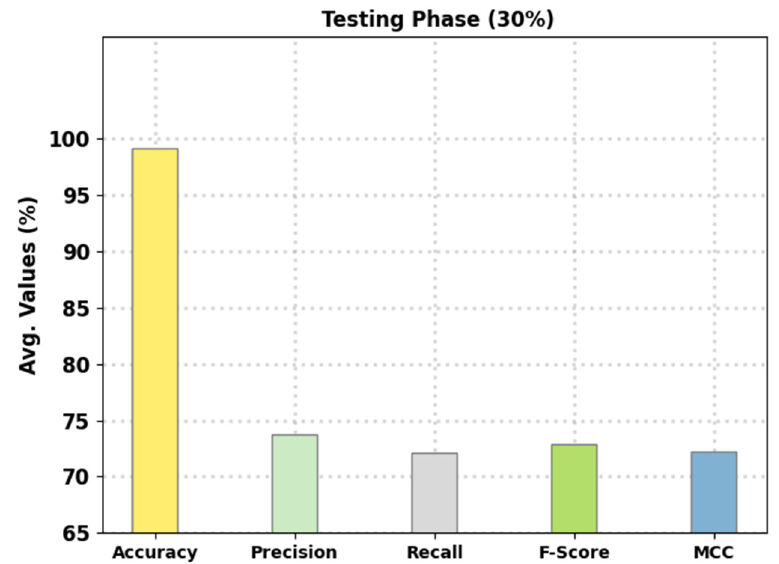
Figure 7. Average analysis of FSHDBN-CID technique under 30% of TS dataset.